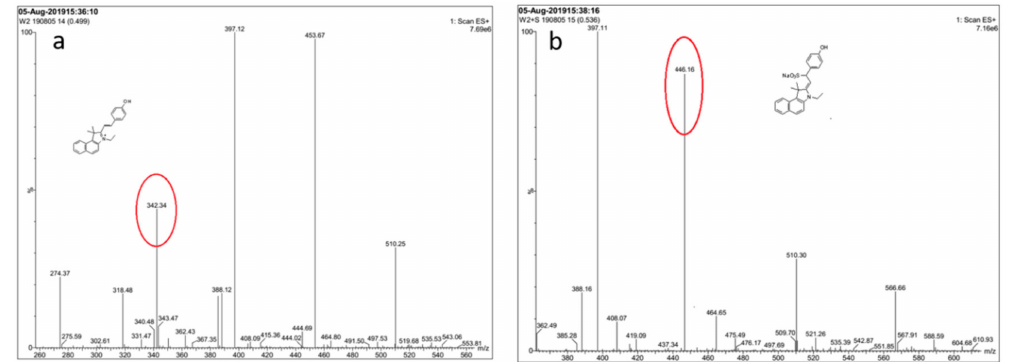
Figure 4. Mass spectrum of probe EB and the crude product of the probe with SO 32 − . ( a ) Probe EB in MeOH. ( b ) Probe EB with Na 2 SO 3 in MeOH: H 2 O